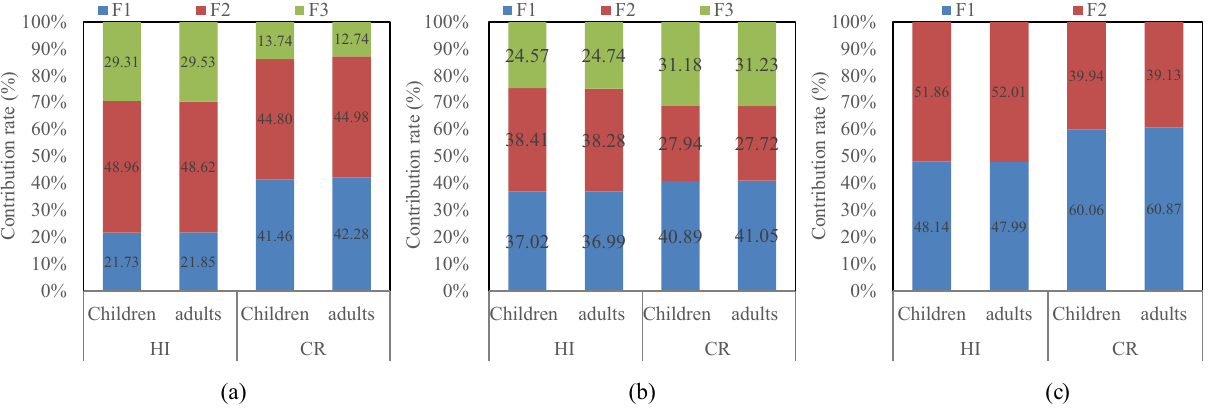
Figure 6. Human health risk proportions of PTEs from different sources in the Aksu Oasis ( a ), Kashgar Oasis ( b ) and Yarkant River Oasis ( c